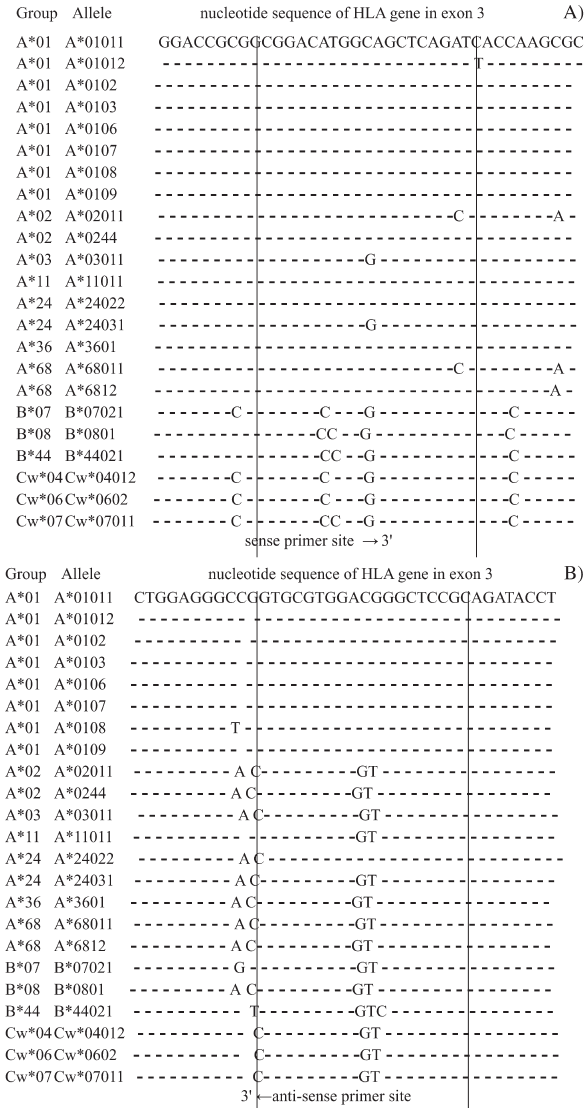
Figure 1 - Comparison of nucleotide sequence alignment showing exon 3 of class I HLA genes. All HLA-A*01 alleles and other HLA-A allele groups which have similar sequence to HLA-A*01 are shown. Other rep- resentativeclassIHLAallelesarealsoshown.Adash(-)indicatesidentity between the sequences. The nucleotide sequence surrounding sense primer site. The nucleotide sequence surrounding anti-sense primer